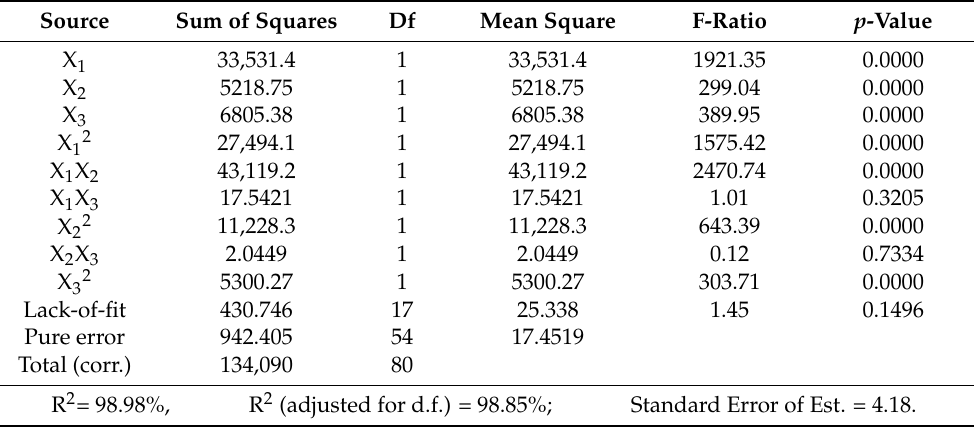
Table 4. ANOVA for the response surface quadratic model for foam expansion volume.